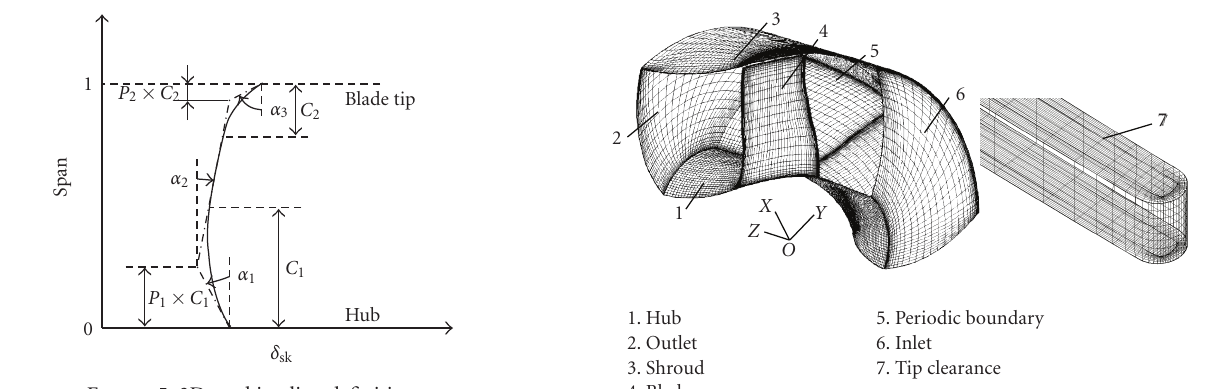
Figure 5: 3D stacking line definition.